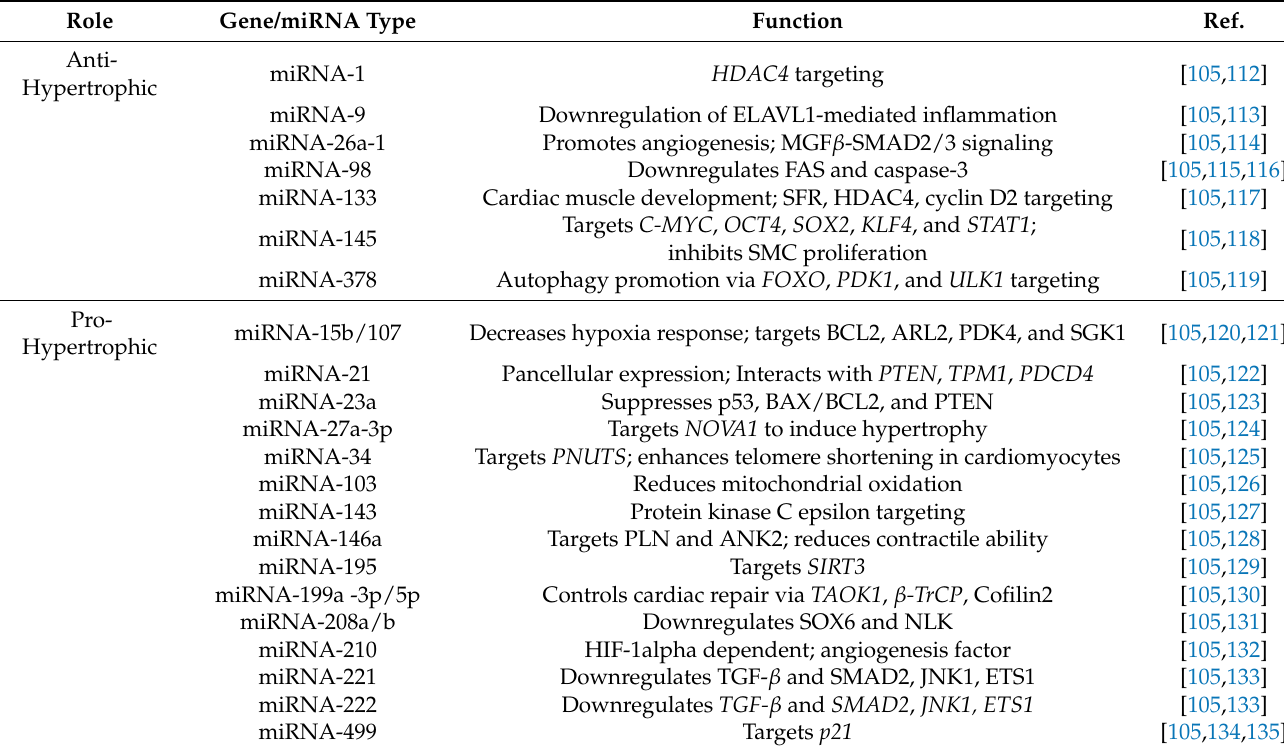
Table 5. Hypertrophy-Modulating Factors Upregulated by Exercise [105,111].